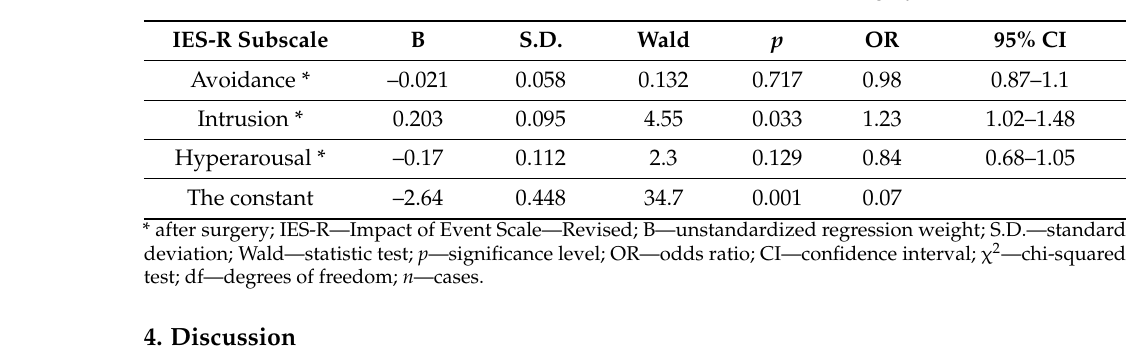
Table 5. The influence of IES-R subscales on suicidal ideation after the surgery ( n =